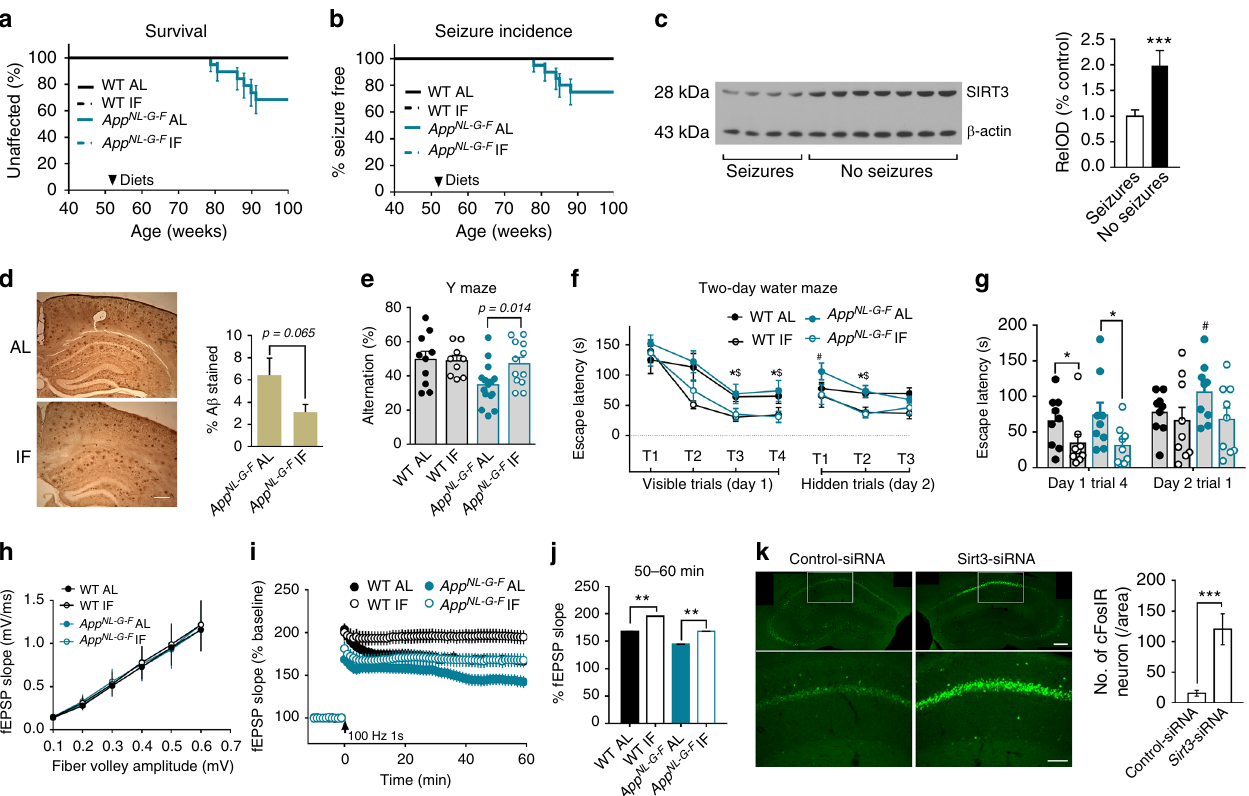
Fig. 3 IF prevents seizures and ameliorates cognitive and synaptic de fi cits in App NL-G-F mice. a Survival curves for WT and App NL-G-F mice maintained on either AL or IF (fasting 2 days/week) diets beginning at 52 weeks of age (WT AL, 10 mice; WT IF, 12 mice; AL App NL-G-F , 19 mice; AD IF, 11 mice. No WT mice or App NL-G-F mice on the IF diet died, whereas 6 mice App NL-G-F mice on the AL diet died. b Age of onset of fi rst seizure-like behavior for mice in the four groups. c Immunoblot analysis of SIRT3 protein levels in hippocampus of App NL-G-F mice in the AL diet group that either did or did not exhibit seizures. Densitometric analysis of SIRT3 band intensity (normalized to actin band; 4 mice with observed seizures, 7 mice without observed seizures). *** P < 0.001. d Images of A β immunoreactivity in hippocampus of App NL-G-F mice that had been on either AL or IF diets for 8 months (scale bar, 100 µ m). The graph shows A β load values (15 sections from 5 mice/group). e Results of Y-maze testing. Group difference, F (3, 32) = 5.538, P = 0.0035. * P < 0.05, WT-AL compared to values for WT-IF; $ P < 0.05, App NL-G-F -AL compared to value for App NL-G-F -IF; # P < 0.05, App NL-G-F -AL compared to each of the other three groups. f , g Escape latencies on testing day 1 trial 4, and testing day 2 trial 1. * P < 0.05 compared to the WT IF group; # P < 0.05, App NL-G-F -AL compared to the other three groups (8 – 11 mice/group). h – j Field EPSP (fEPSP) recordings at CA1 synapses. Panel h shows basal synaptic transmission. i shows the results of LTP analysis. j shows quanti fi cation of LTP magnitude (10 slices from 5 mice/group). ** P < 0.01. k c-Fos immunoreactivity in hippocampal CA1 neurons of an App NL-G-F IF mouse one month after administration into the dorsal hippocampus of control shRNA lentivirus in the left hippocampus (left panels) and a lentivirus with an shRNA targeting Sirt3 RNA in the right hippocampus (right panels). (Scale bar, upper 250 µ m, lower 100 µ m). *** P < 0.001. All error bars are the SEM. Student ’ s t test was used for analyses of data in c , d and k . ANOVA and Newman – Keuls post-hoc tests were used for analyses of data in e , f , g , i and j . Source data for all graphs in this fi gure are provided in supplemental Source Data fi